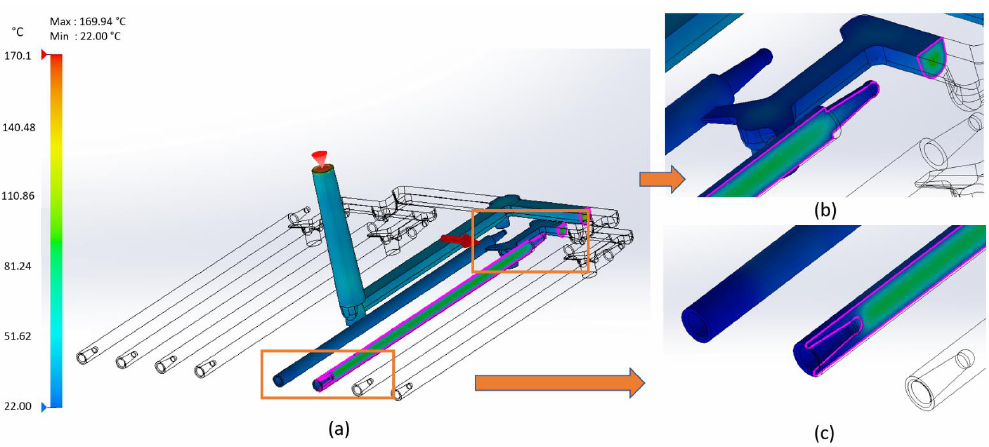
Figure 8. ( a ) Temperature at the end of packing — clipping section through the stick; ( b ) external joint areas; and ( c ) internal joint areas.